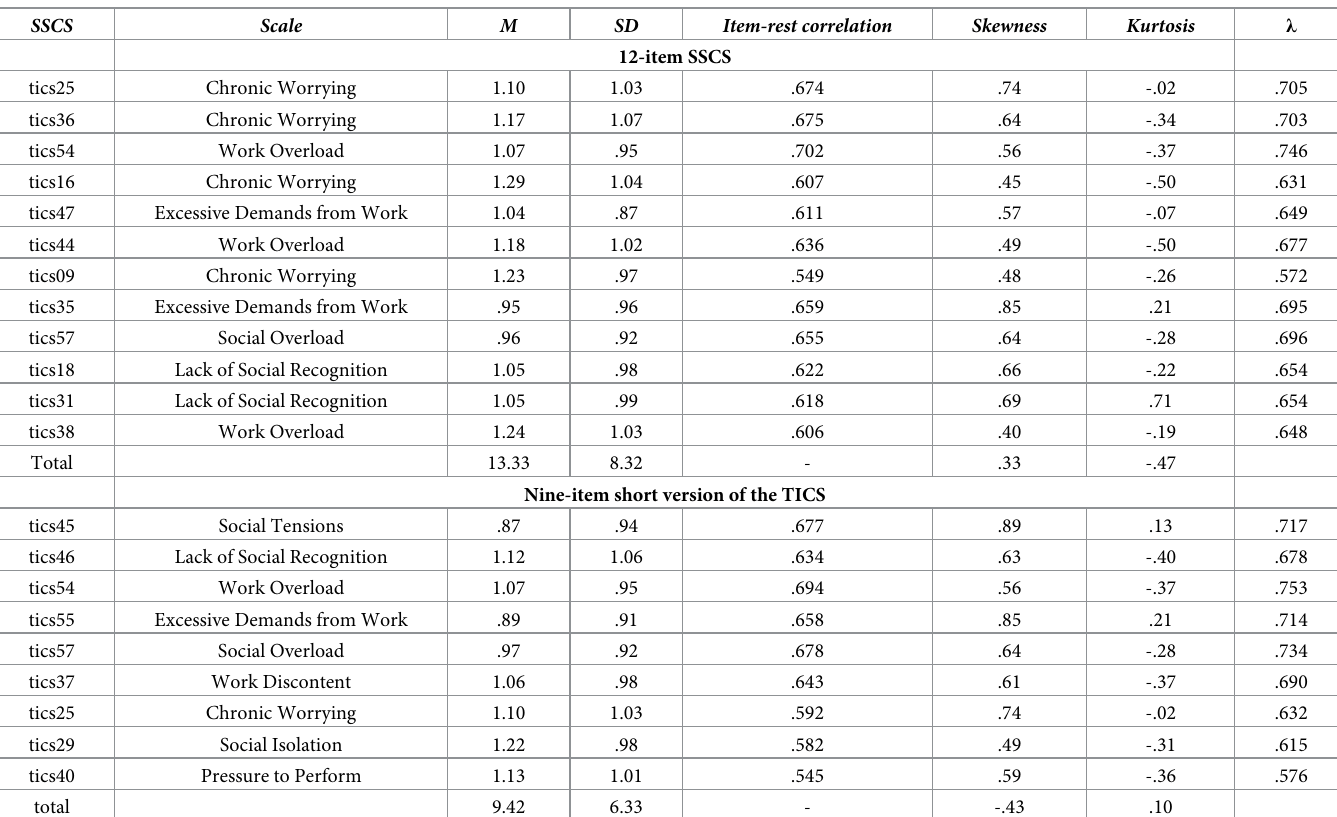
Table 1. The 12-item SSCS and the new nine-item short version of the TICS and its item discriminative power (N =